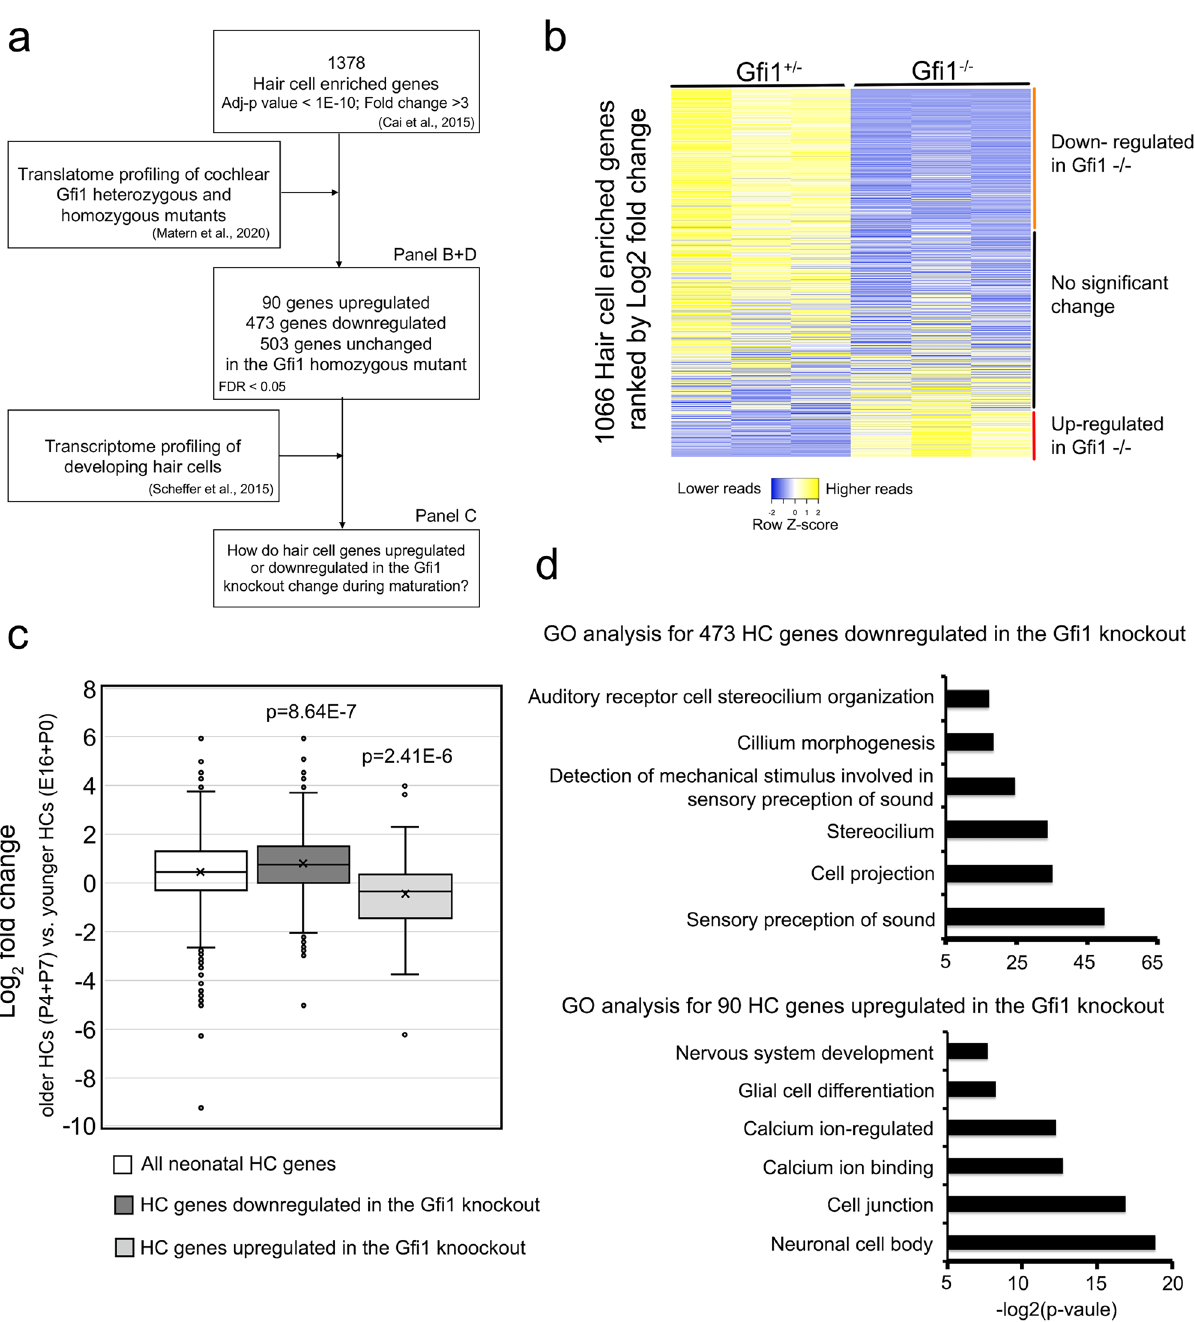
Figure 1. GFI1 differentially regulates expression of hair cell genes during inner ear development. ( a ) Overview of the analysis workflow: We used our previously published RNA-seq data from neonatal hair cells 38 to identify a list of 1378 genes enriched in hair cells. We then cross-referenced this list with RNA-seq translatome data from Gfi1 mutant or heterozygote hair cells 30 to identify genes that were up-or-down-regulated in Gfi1 null mice. We then examined how expression of these GFI1-regulated genes varied in hair cells with developmental time, but using data from E16, P1, P4 and P7 purified hair cells 40 . ( b ) Heat map for the expression of hair cell-enriched genes in Gfi1 heterozygous and null mice showing. The orange-labeled cluster represents genes significantly downregulated in Gfi1 homozygous mutant hair cells, the red-labeled cluster represents genes that are significantly upregulated in the Gfi1 mutant, and the black-labeled cluster shows genes that are not significantly changed in mutant hair cells. ( c ) Box plot showing that the 473 hair cell genes that are down-regulated in the Gfi1 knockout tend to be expressed at higher levels in more mature (P4 and P7) hair cells, while the 90 hair cell genes that are up-regulated in the Gfi1 knockout tend to be expressed at a lower level in more mature hair cells. Statistical significance was assessed by a Student t-test, comparing the Log 2 fold change (FC) values of each gene group to the log 2 FC values of all neonatal hair cell genes. ( d ) Gene ontology analysis of hair cell-enriched genes that are either down-regulated (473 genes) or up-regulated (90 genes) in the Gfi1